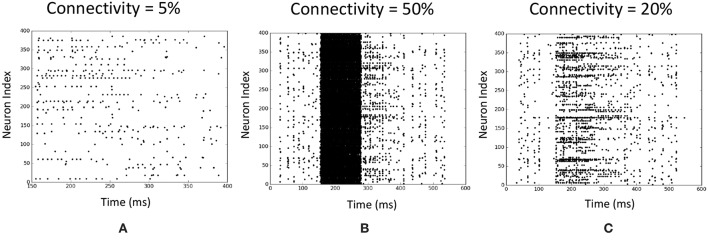
Illustration of two negative behaviors of an LSM at different input to liquid percentage connectivity values. Each raster plot shows the spiking activity of the liquid neurons over time. The application is a speech recognition task (TI-alpha). (A) Over-stratification at low percentage connectivity. (B) Pathological synchrony at higher percentage connectivity. (C) An instance that shows clear differences between spiking activity of the liquid neurons in contrast to (A,B).